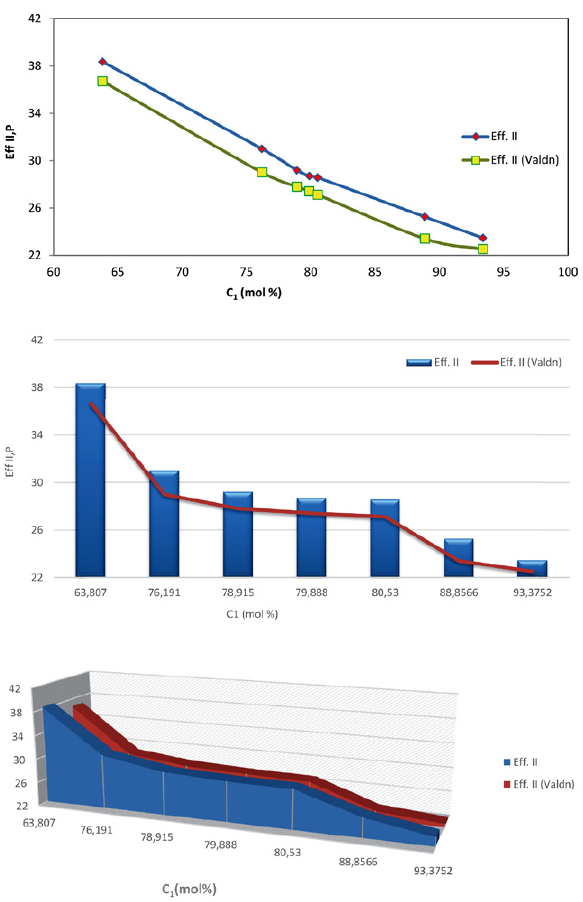
Fig. 5. Effect of methane concentration variation on exergetic Effi- ciency (%)